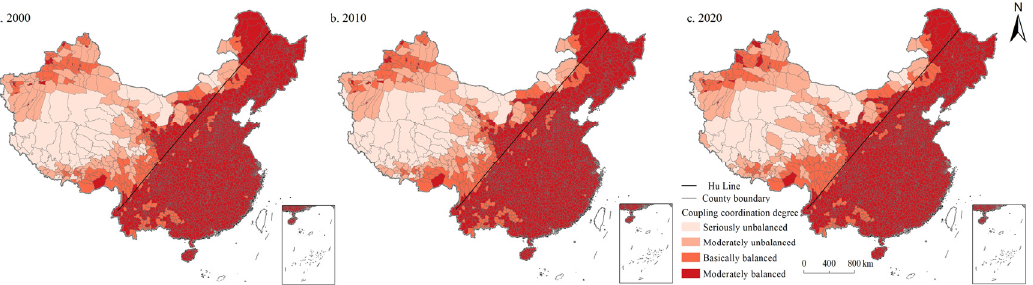
Figure 6. Spatial distribution of coordination degree of PSI and ESI in China during 2000–2020.